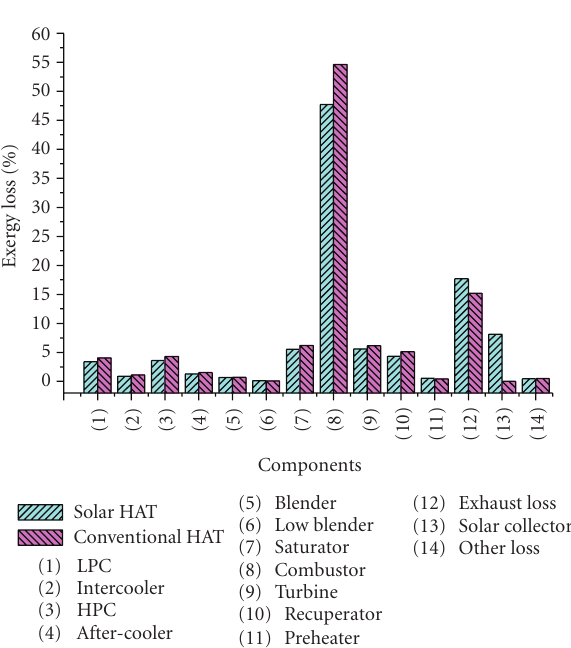
Figure 7: Exergy losses ratio of components in total exergy